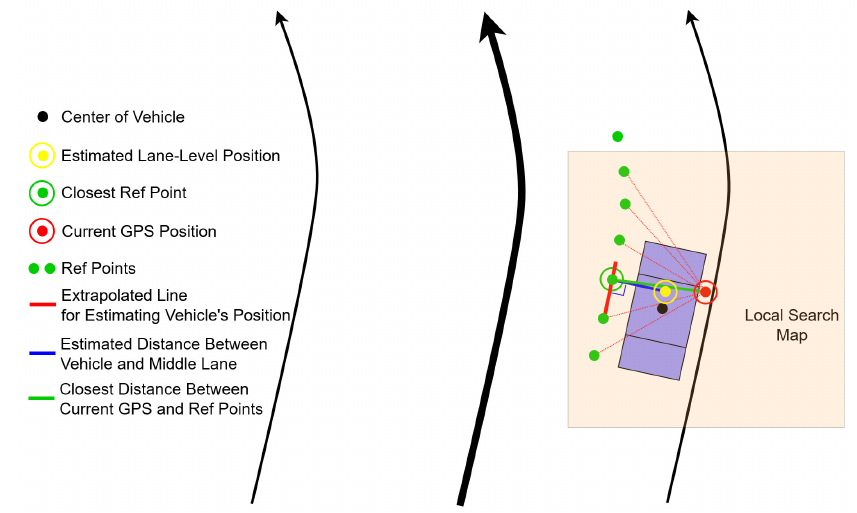
Figure 7. Illustration of estimating vehicle’s position based on